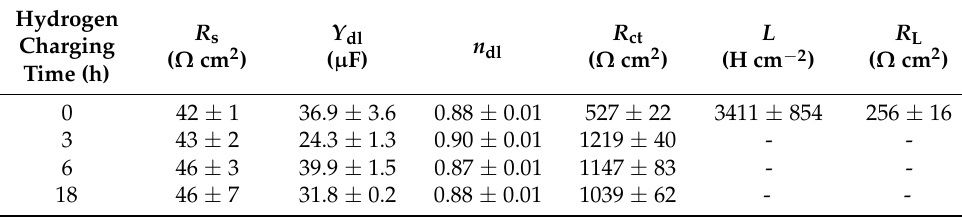
Figure 7. Nyquist plots and equivalent circuits of differently charged samples measured in a 0.1 M NaCl solution: ( a ) Nyquist plots, ( b ) equivalent circuit of uncharged sample and ( c ) equivalent circuit of 3, 6 and 18 h charged samples. Table 3. The fitting EIS data of differently charged samples based on the equivalent circuits.